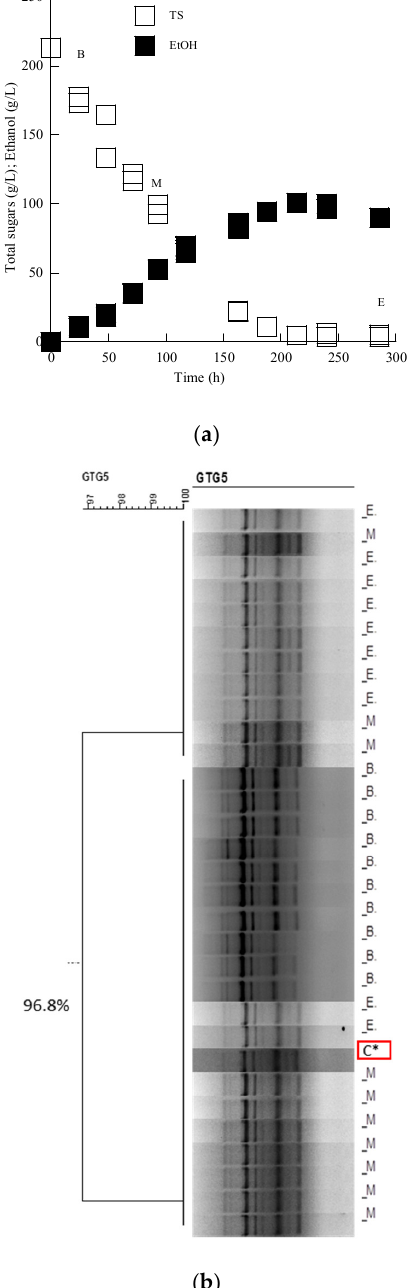
Figure 5. ( a ) Sugar and ethanol evolution of the S. cerevisiae LMBF Y-54 strain in must from the grape variety Mavrotragano. Each experimental point is the mean value of 2 independent measurements (SE for most experimental points ≤ 17%). ( b ) Dendrogram generated after cluster analysis of the digitized (GTG)5-PCR fingerprints of the 31 isolates from the beginning (B), middle (M) and end (E) of the fermentation kinetics in the grape must media. The control condition (C*) is the relative rep-PCR profile of the pure culture of the S. cerevisiae LMBF Y-54 strain. The dendrogram was constructed using the unweighted pair-group method using arithmetic averages with correlation levels expressed as percentage values of the Pearson correlation